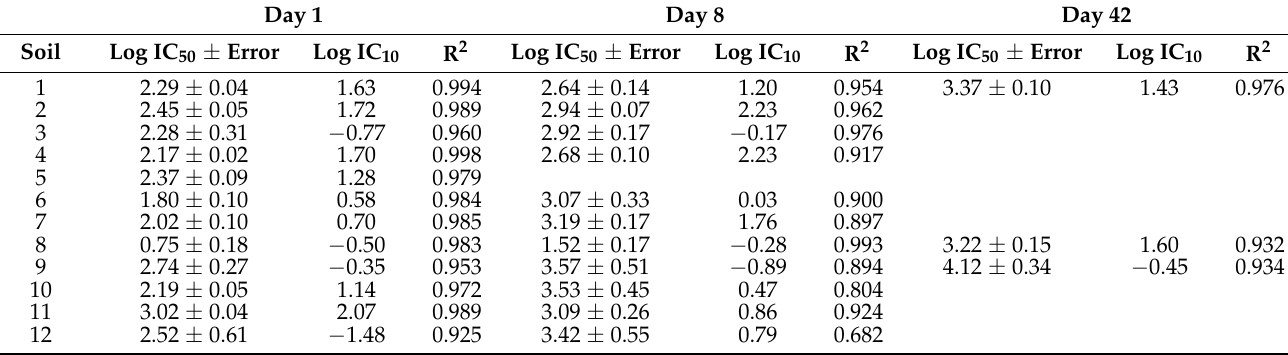
Figure 1. Relative bacterial community growth as a function of clarithromycin (CLA) concentration in the 12 soils studied, after 1, 8, and 42 days of incubation. Table 2. Toxicity exerted by clarithromycin on the growth of soil bacterial communities estimated as Log IC 10 and Log IC 50 values (mean values with the standard error range in brackets) after 1, 8, and 42 days of incubation. R 2 values represent the coefficients of determination for model fits used for Log IC 50